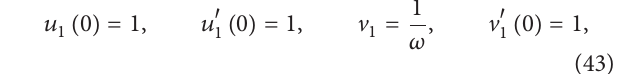
Figure 9: Efficiency curves for Problem 5.